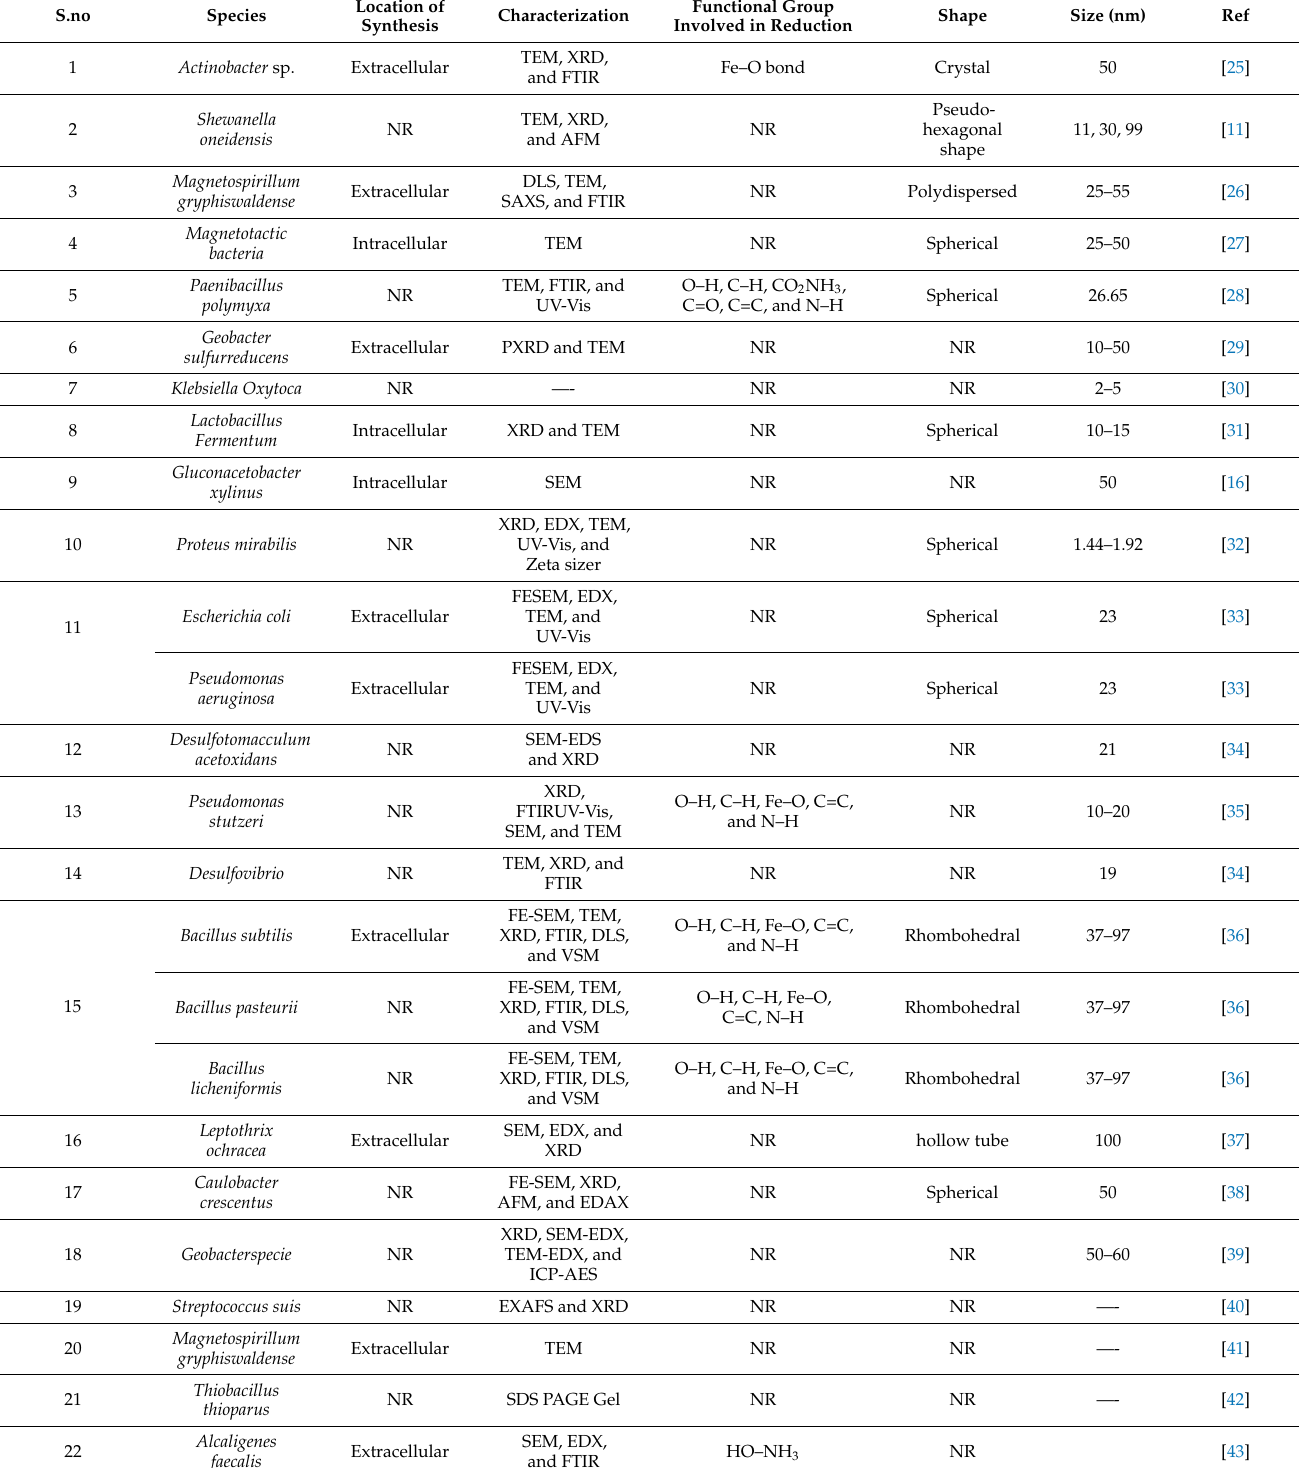
Table 1. Bacterial mediated Iron